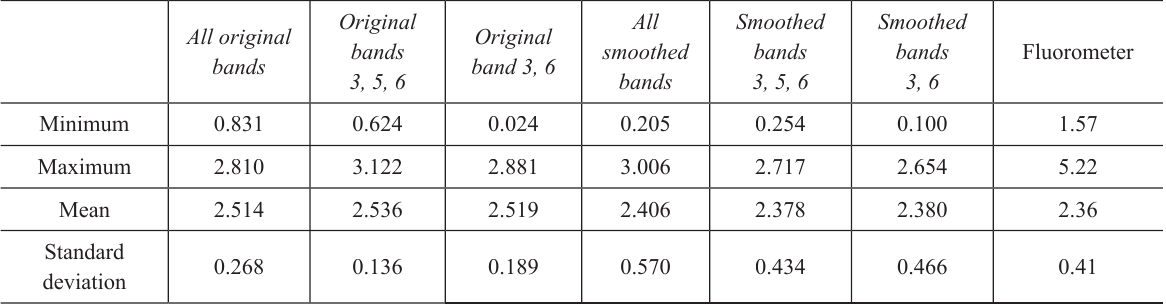
Descriptive statistics of the attributes estimated by ANN different architectures.